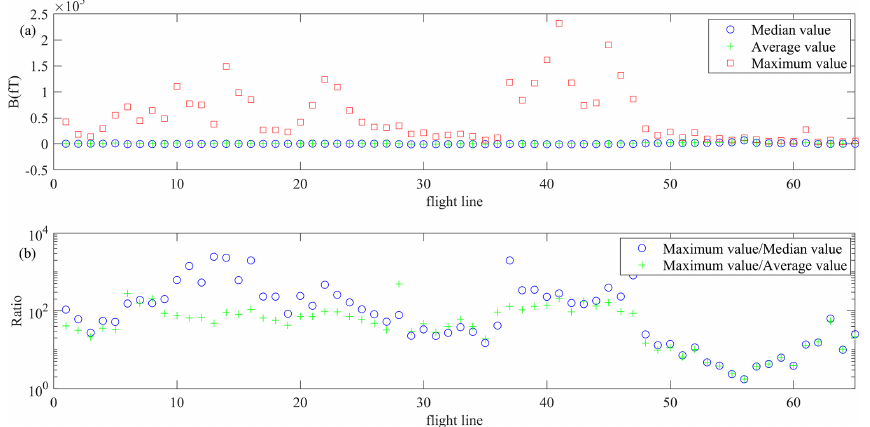
Figure 9. Statistical values of the raw AEM data. (a) The median value, average value and maximum value of each flight line in the field. (b) The ratio of the maximum value to the median value and of the maximum value to the average value. For a better visualization effect, the ratio curves are shown in logarithmic